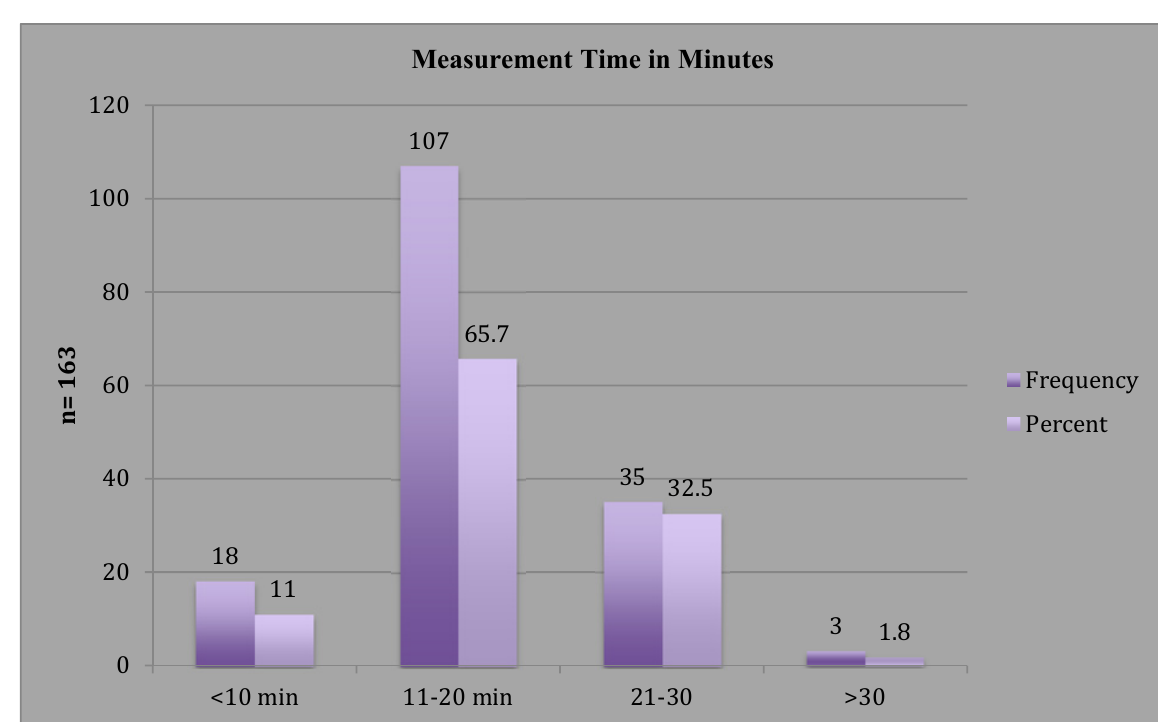
Figure 2. Measurement Time in Minutes by Visit.